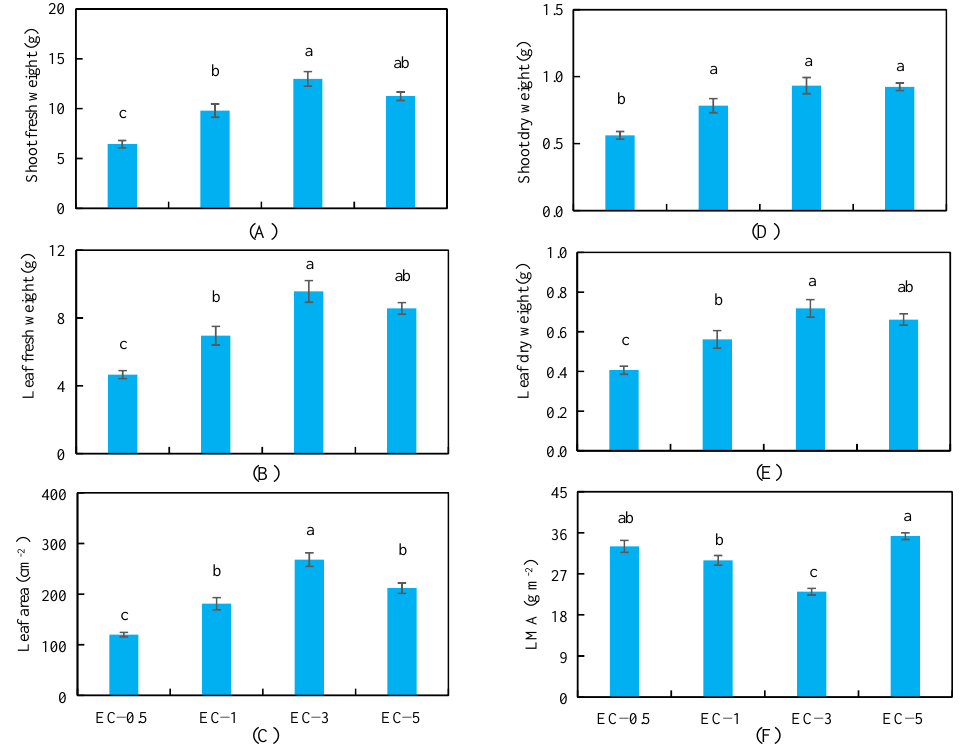
Figure 2. Shoot fresh weight ( A ), leaf fresh weight ( B ), leaf area ( C ), shoot dry weight ( D ), leaf dry weight ( E ), and leaf dry mass per area (LMA) ( F ) of basil plants under 4 different EC treatments at 34 days after sowing. The error bars represent SEs ( n = 12). Different lowercase letters represent significant differences among different EC treatments based on Tukey’s new multiple range test at p < 0.05.